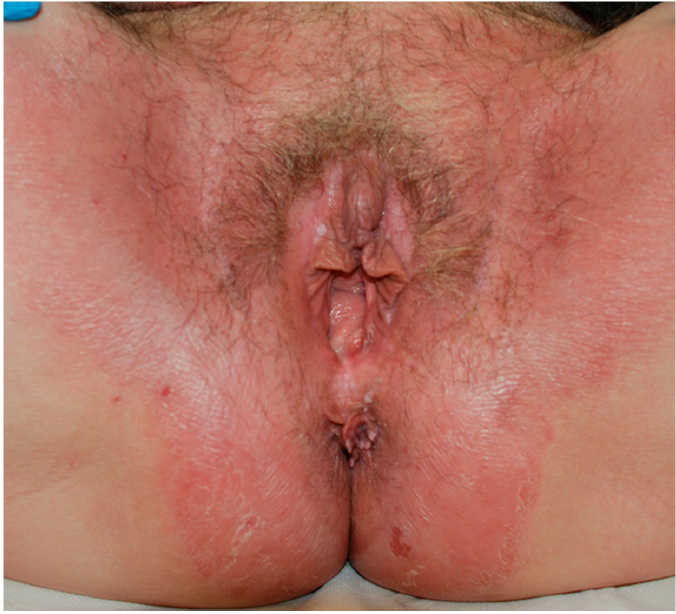
Allergies 2021 , 1 , FOR PEER REVIEW Figure 1. A case of psoriasis complicated by allergic contact dermatitis due to topical medications.